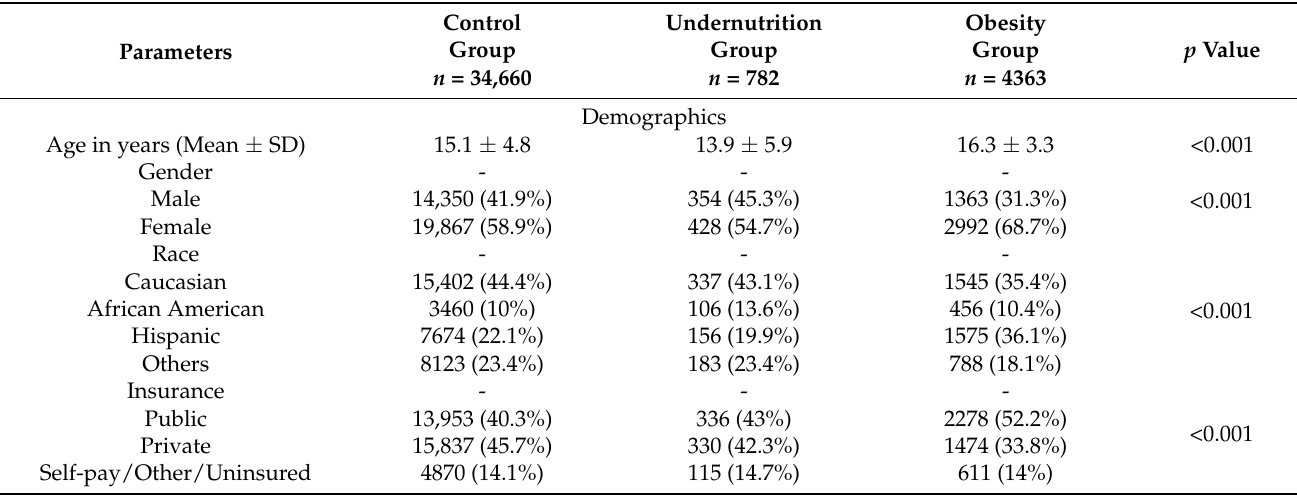
Table 1. Comparison of various demographics, hospital factors, etiologies, and associated comorbid diseases of acute pancreatitis. Patients are classified based on nutritional status: Kids’ Inpatient Database 2003, 2006, 2009, 2012, and